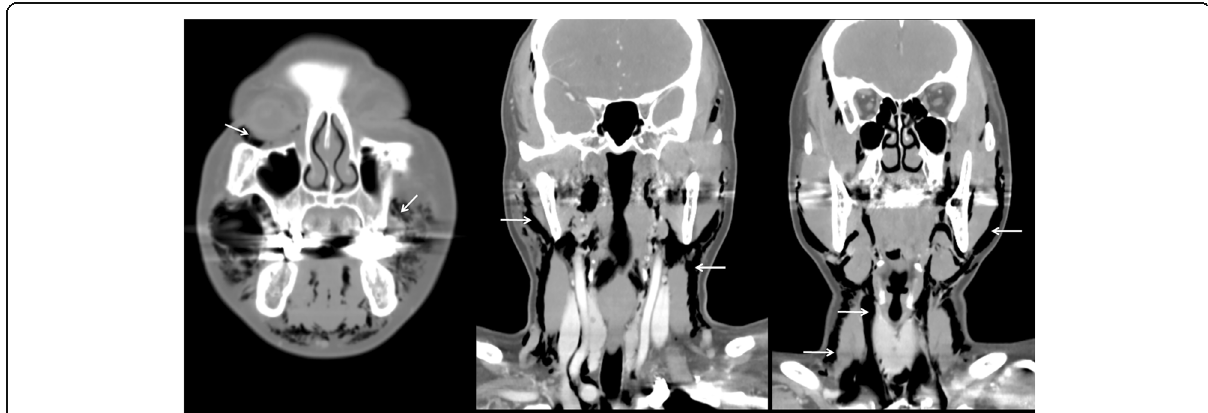
Fig. 3 Paranasal sinus computed tomography (PNS CT [coronal view]) of emphysema in the retromandibular, visceral, and retropharyngeal spaces